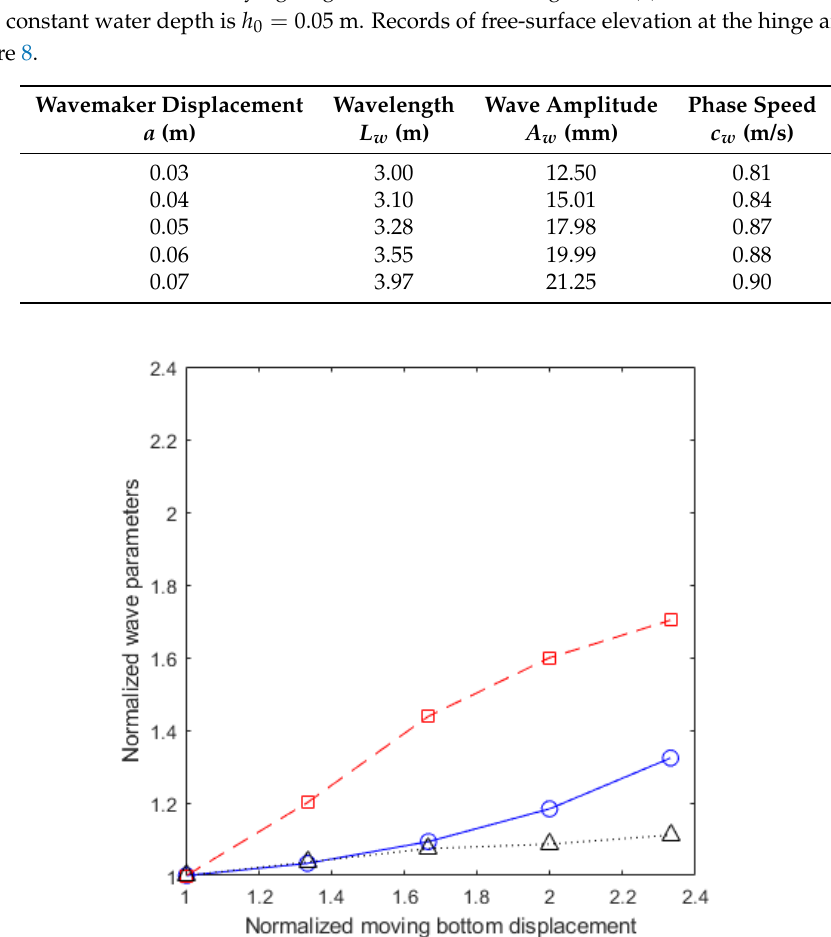
Figure 7. Normalized wave parameters vs. normalized magnitude of vertical wavemaker displacement, a / a 0 . Square: wave amplitude, A w / A w ,0 ; circle: wavelength, L w / L w ,0 ; triangle: phase speed, c w / c w ,0 . Subscript 0 indicates the normalization by the corresponding values at a = 0.03 m (see Table 2). In all cases, h 0 = 0.05 m, L = 1 m, b = 0.5 s, θ = 0, and the upward bottom motion, (1), is